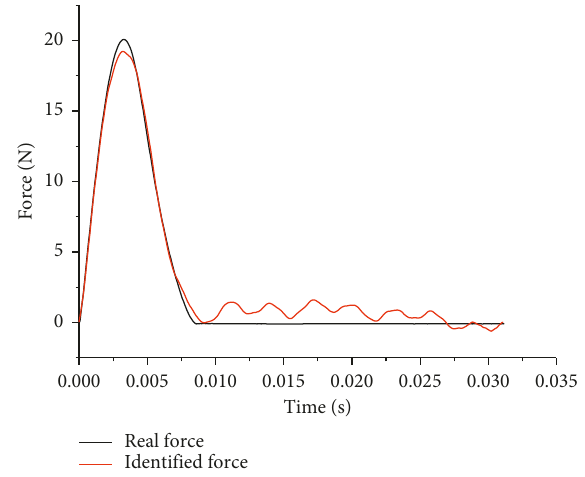
Figure 20: The reconstruction of the impact